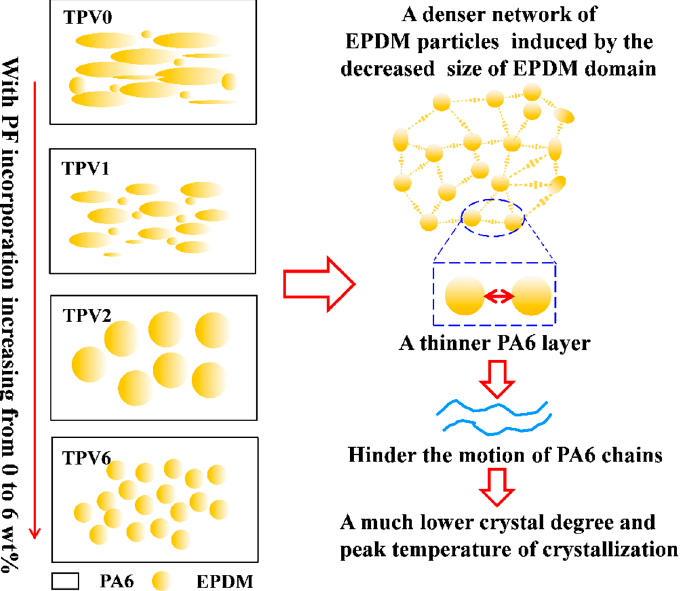
Figure 10. Schematic representation of the structure evolution of TPVs based on PA6 / EPDM subjected to an increasing crosslinking degree.